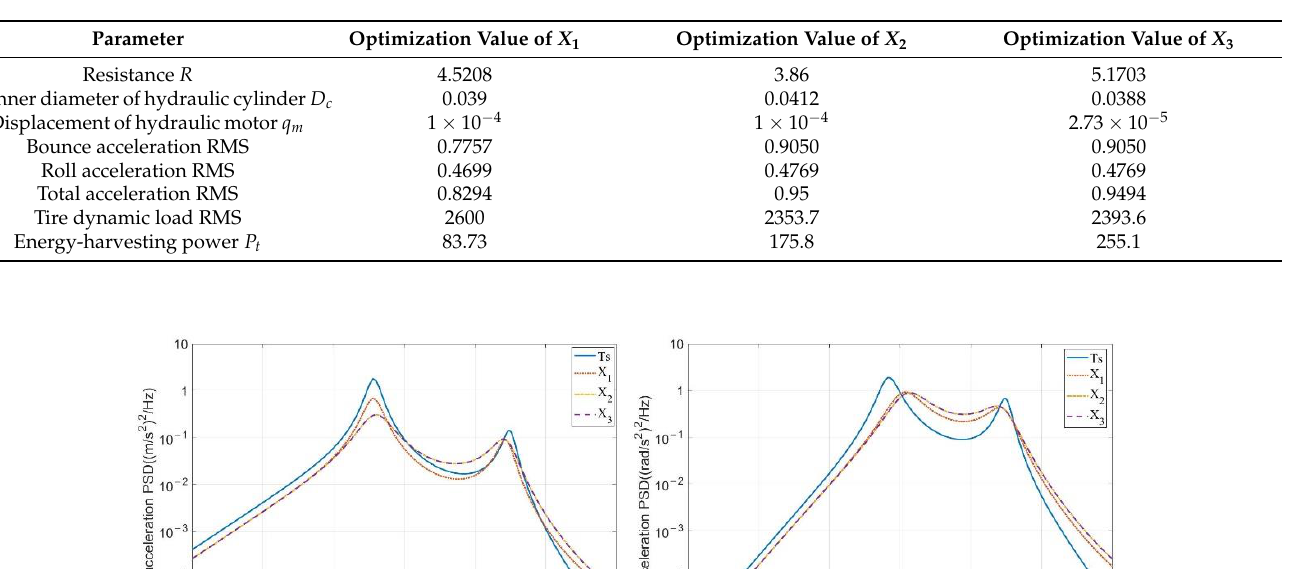
Table 8. Optimization results.